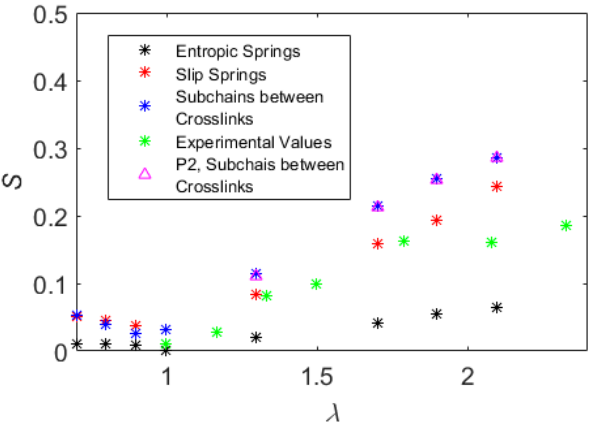
Figure 9. Largest eigenvalue of Q (parameter S ) of a crosslinked polymer network containing 600 crosslinks and 900 slip springs as a function of the relative elongation λ (compression: λ < 1, elongation: λ > 1) at three different length scales, i.e., entropic springs (strands), slip springs, and subchains connecting successive crosslinks along the polymer chains. Order parameters, as defined from Equation (44), are also included for the simulated polymer network. Experimental values based on Fourier transform infrared spectroscopy (FTIR) are from [103,104].